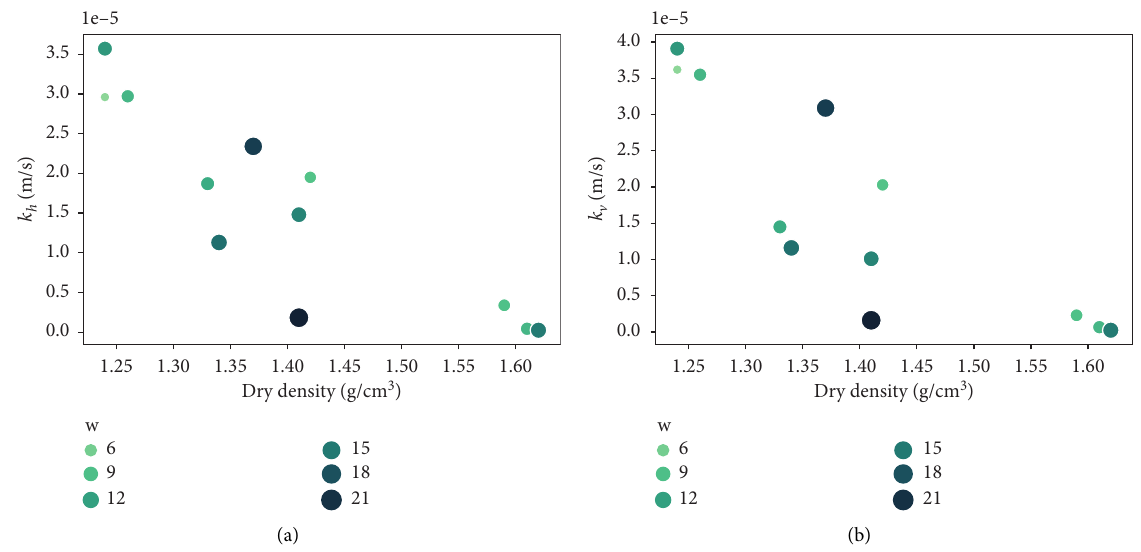
Figure 12: Relationship curve between permeability coefficient and dry density of the intact loess under different water contents. (a) Horizontal permeability coefficient. (b) Vertical permeability coefficient.